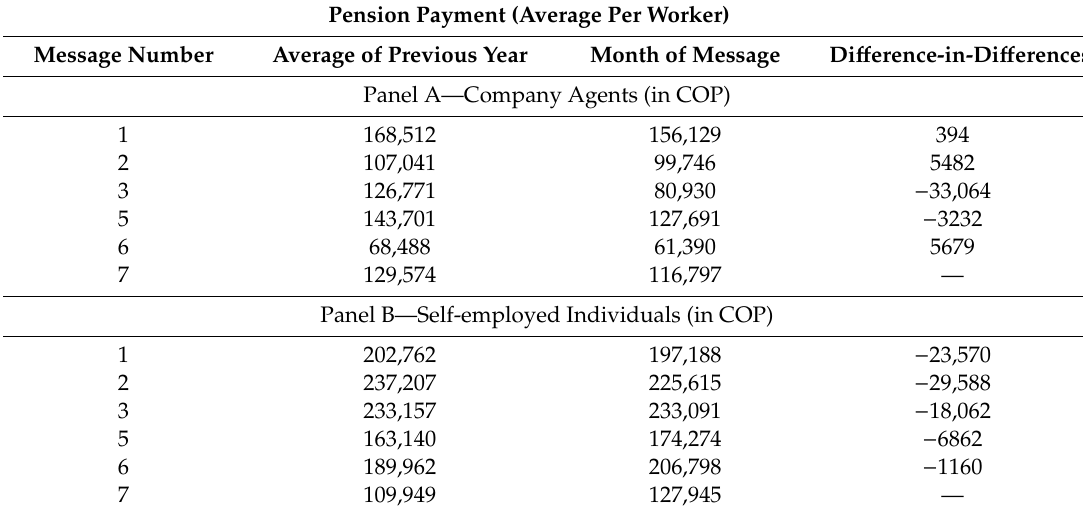
Table 5. Pension Payments with “Neutral Message 7 as Control Group”— Pago